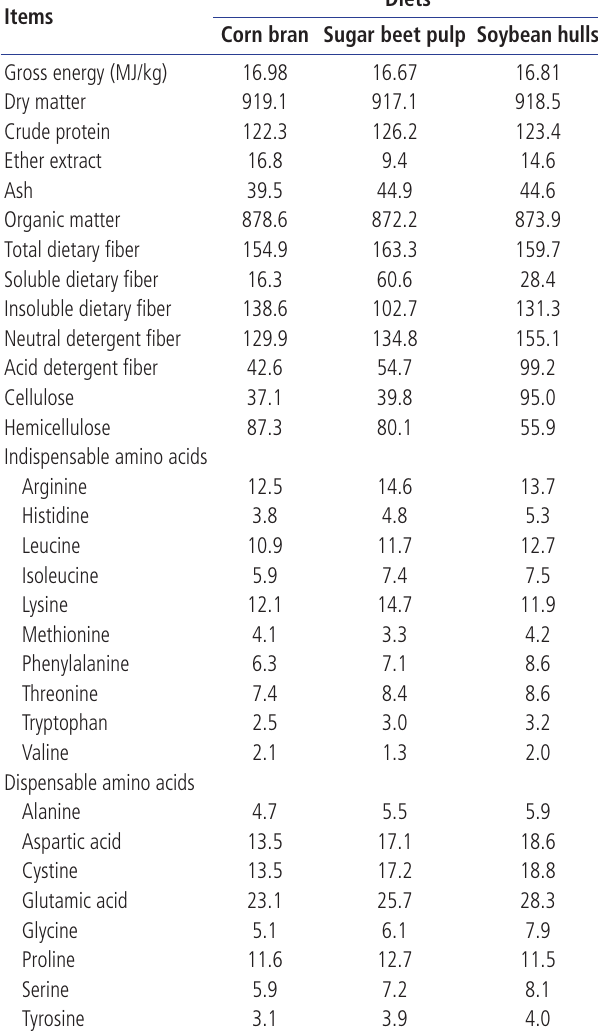
Table 2. The composition (g/kg, as-is basis) of the experimental diets Items